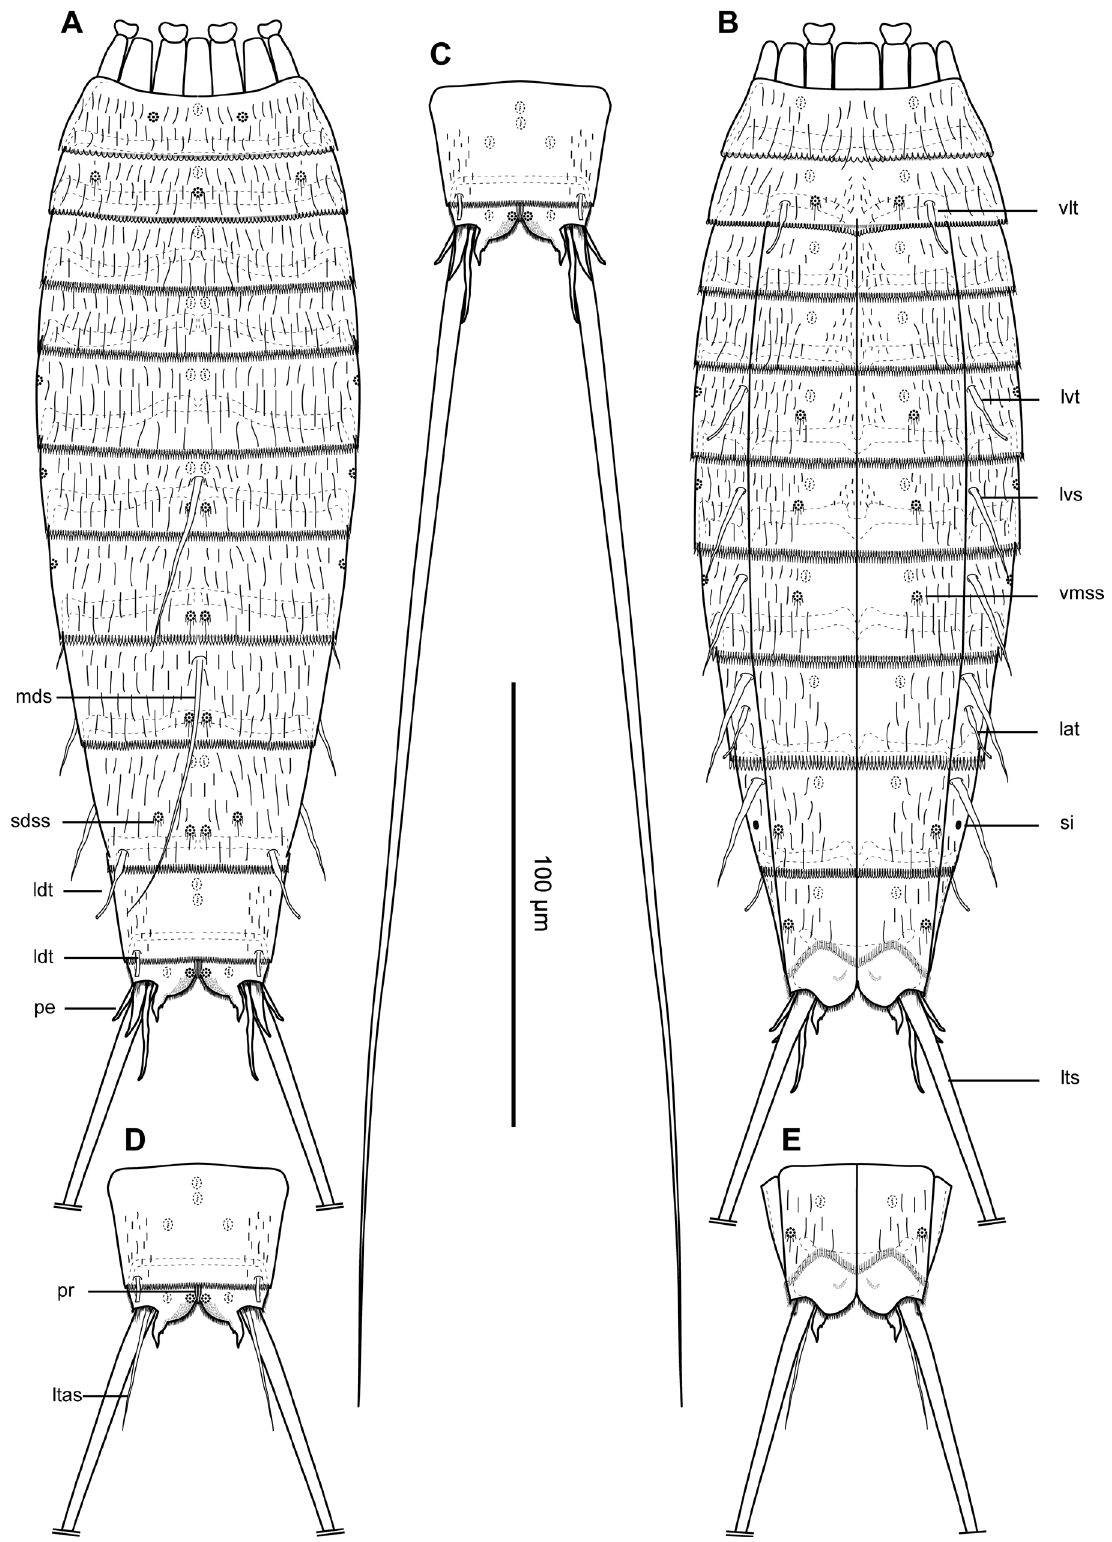
Fig. 14. Line art illustrations of Echinoderes gandalfi sp. nov. A . ♂, dorsal view. B . ♂, ventral view. C . ♂, segments 10 to 11, with lateral terminal spines drawn in full length, dorsal view. D . ♀, segments 10 to 11, dorsal view. E . ♀, segments 10 to 11, ventral view. Abbreviations: see Material and